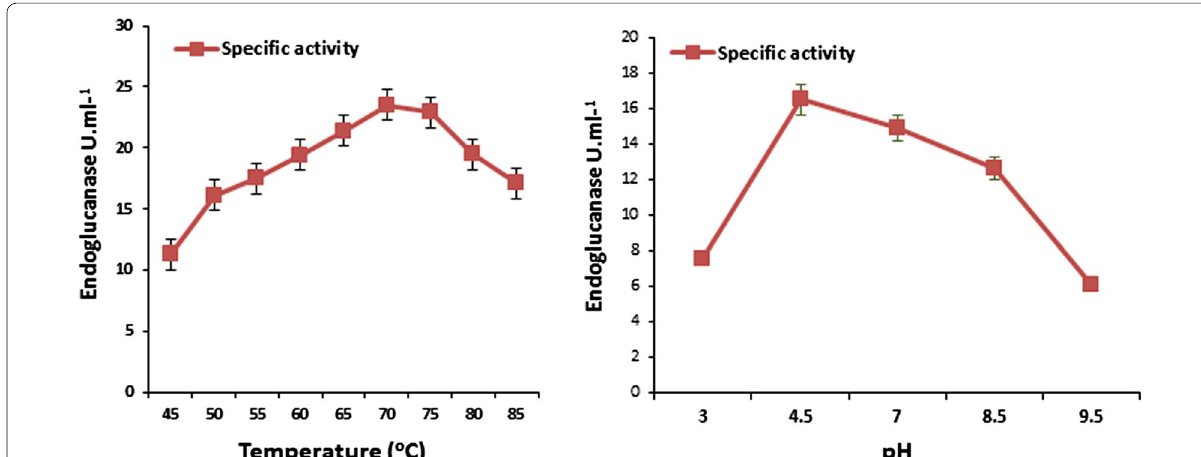
Fig. 7 Effect of temperature and pH on endoglucanase activity for the strain Bacillus licheniformis KBFB3. The optimum pH and temperature for endoglucanase activity for the best isolate Bacillus licheniformis KBFB3 was determined by growing it in production media amended with CMC 1% in the different range of temperature and